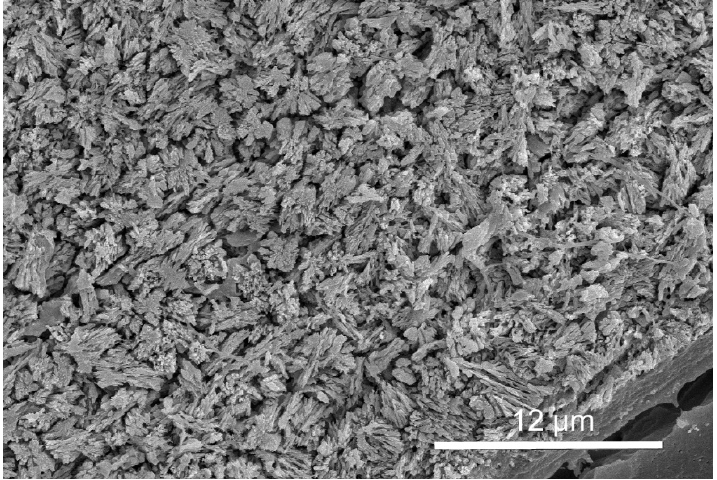
Figure 5. The longitudinal section of ARHC structure in Pomatostegus stellatus .